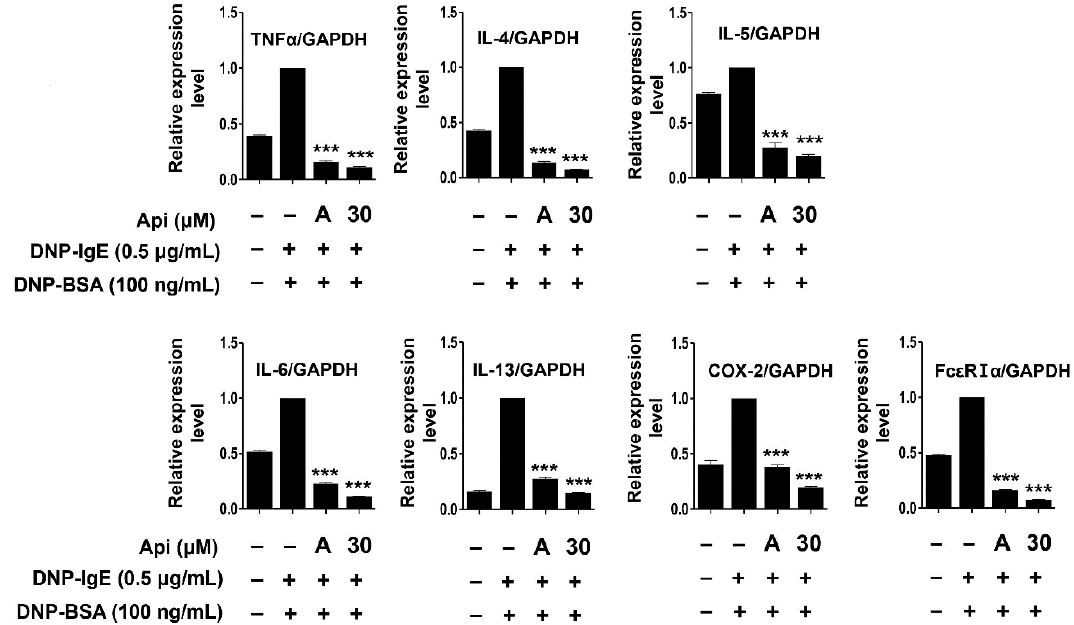
Figure 4. Effects of apigenin on the mRNA transcription of cytokines and Fc ε RI α in RBL-2H3 cells. Cells were treated with apigenin (30 µ M), 0.5 µ g / mL DNP-IgE, and 100 ng / mL DNP-BSA. Api, apigenin; A, cyclosporine A (1 µ g / mL). The data were analyzed using one-way analysis of variance (ANOVA) followed by Tukey’s test. *** p < 0.001 versus DNP-IgE- and DNP-BSA-treated cells without